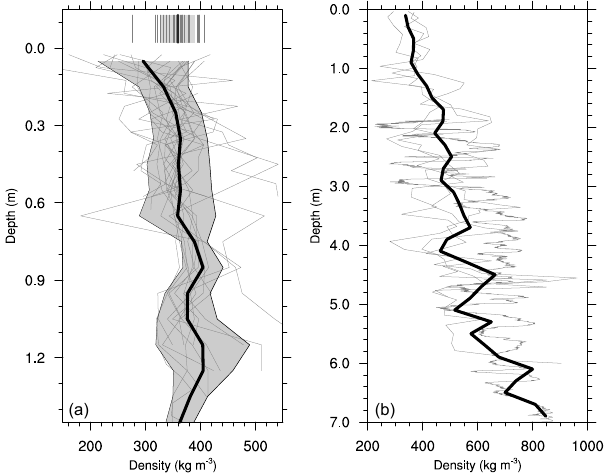
Figure 4. Vertical profiles of snow and firn density used to convert the observed surface height changes to mass fluxes. Thin grey lines represent all individual profiles, and thick lines indicate mean den- sity profiles. (a) Snow pit observations between 0 and 1.50m. Grey shading indicates a vertical profile of standard deviation. Vertical bars in the top of the panel are vertically integrated densities, in- cluding the mean vertically integrated density as a thick bar; (b) firn core observations (gravity coring and OPTV logging) up to 7m be- low the surface. Note different depth and density scales between the panels.